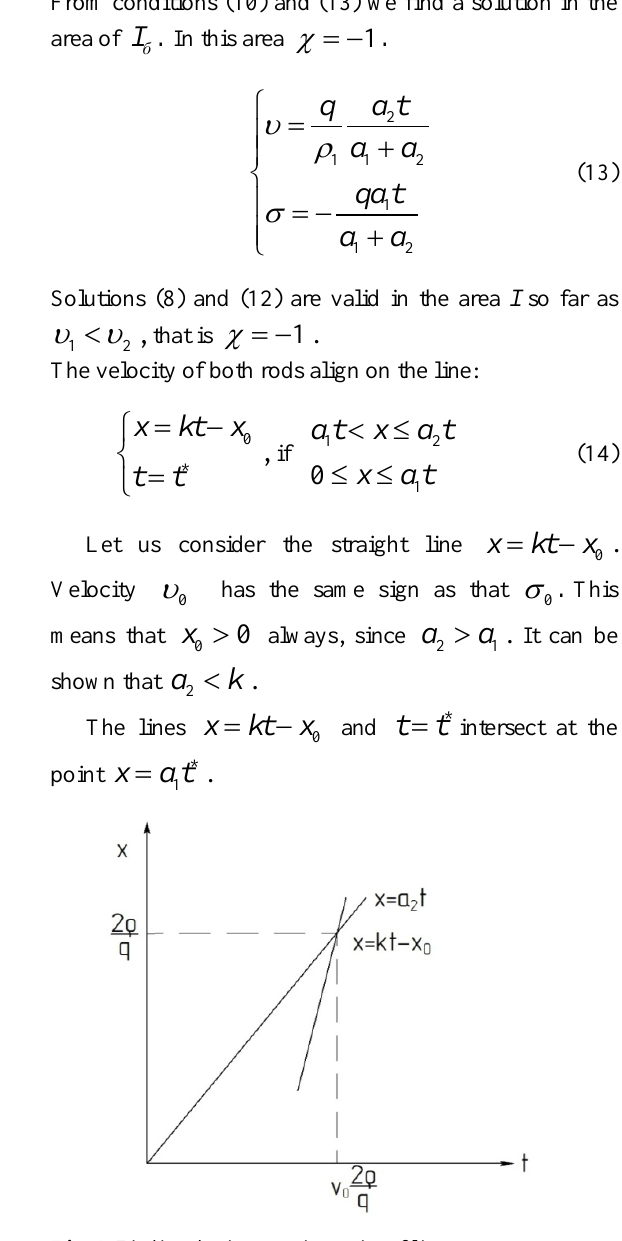
Fig. 4. Finding the intersection point of lines. This means that the polygonal line (14) is continuous. On the line (14) the velocity of cross- υ and υ are aligned, but what further sections 2 1 movement will be -